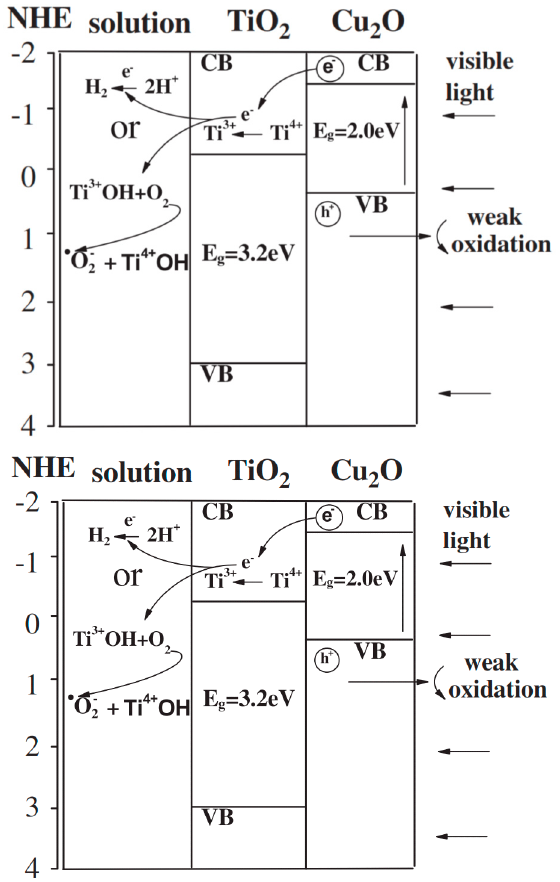
Figure 12. Interfacial electron transfer in Cu 2 O/TiO 2 composite in the presence of Ti 3+ . Reprinted with permission from [99]. Copyright Elsevier, 2011.